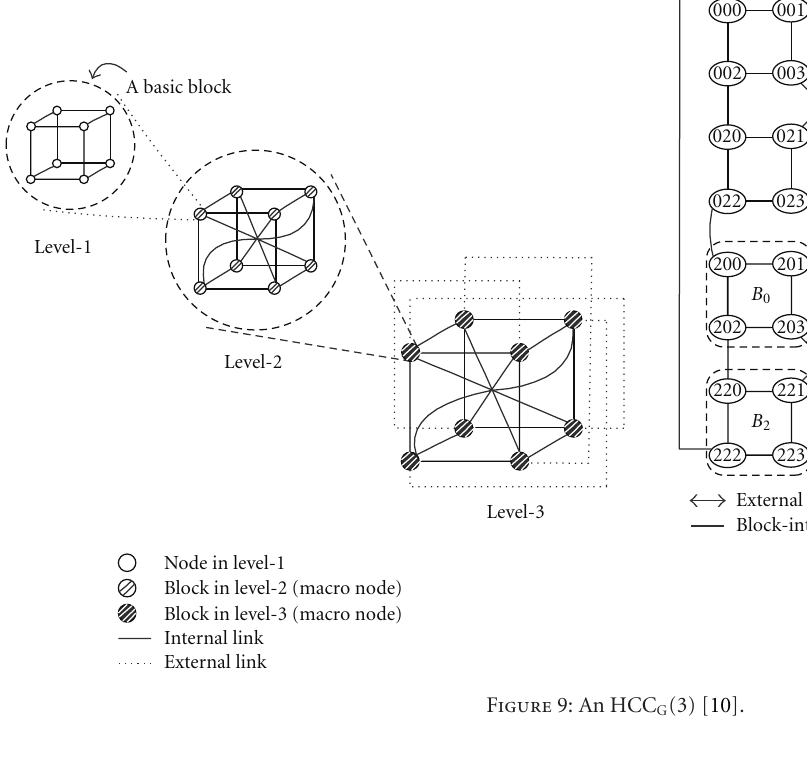
Figure 9: An HCC G (3) [10].